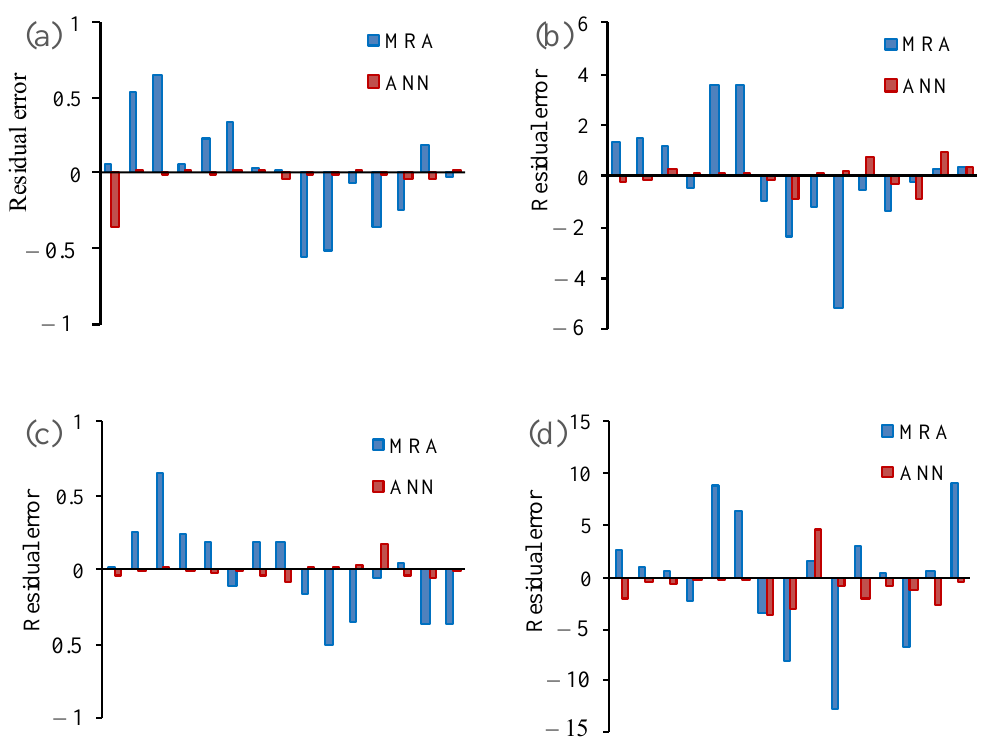
Figure 17. Residual error plots of MRA and ANN models to predict ( a ) Id 2 , ( b ) SRH, ( c ) UPV, and ( d ) UCS.